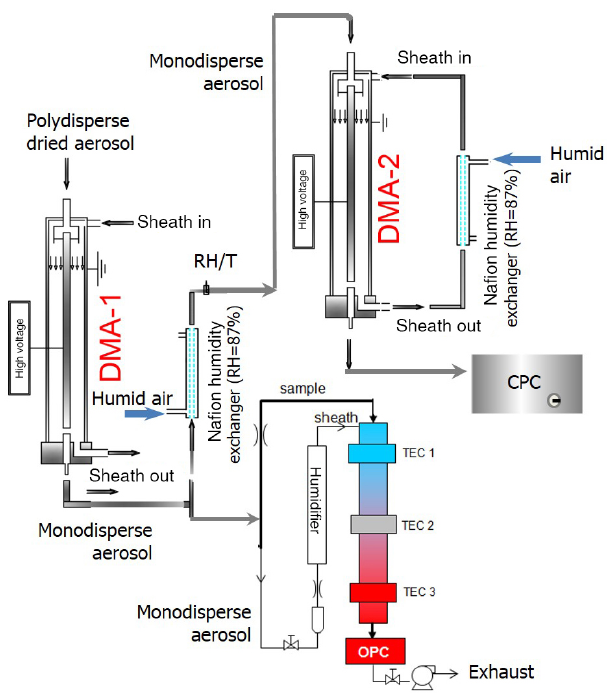
Figure 1. Schematic of the setup used for the CCN and mixing state